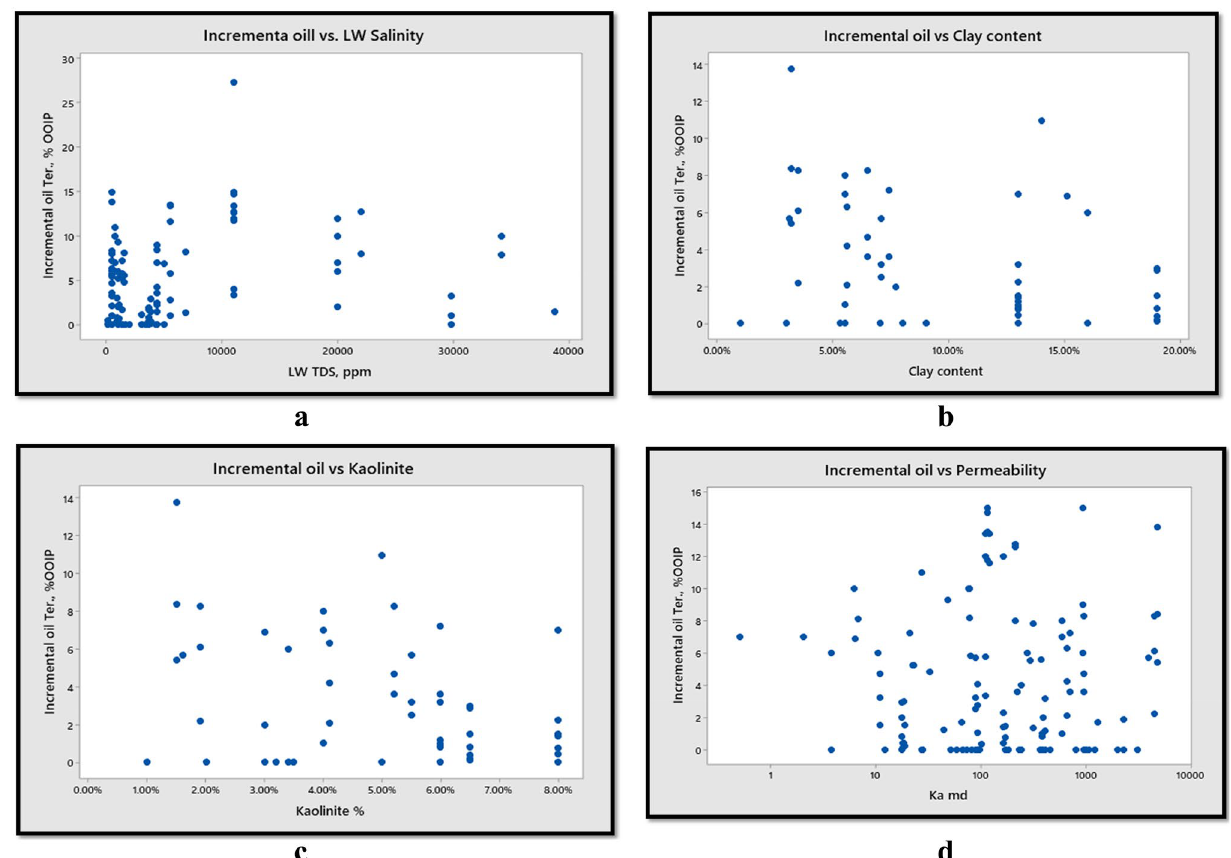
Fig. 2 a Tertiary incremental versus LW salinity of the literature data. b Tertiary incremental versus clay content of the literature data. c Tertiary incremental versus kaolinite of the literature data. d Tertiary incremental versus permeability of the literature